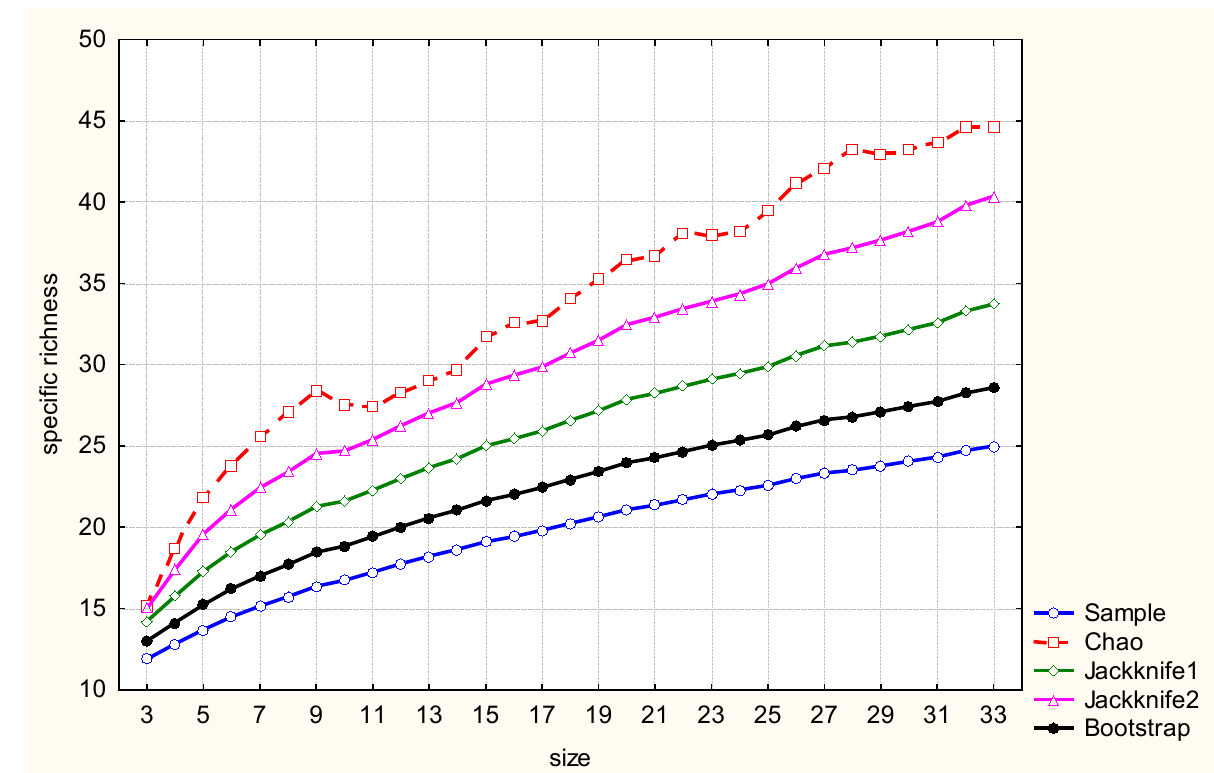
Fig 7 .Curves of accumulation of the species, estimators of the richness in